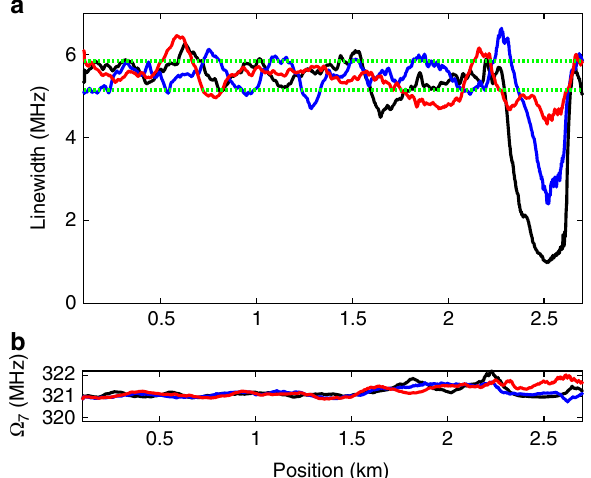
Fig. 4 Optomechanical time-domain re fl ectometry spectra. Measured normalized nonlinear coef fi cients γ (7) ( Ω ) at speci fi c fi bre locations (blue Fig. 5 Optomechanical time-domain re fl ectometry measurements. circular signs) are shown alongside fi tted Lorentzian line-shapes (red solid a Measured linewidths Γ 7 ( z )/2 π as a function of position. b Measured R γ 7 ð Þ Ω ð Þ d Ω is the traces). The nonlinear coef fi cients are normalized so that resonance frequencies Ω 7 /(2 π ) as a function of position. The standard same for all measurements. A standard, single-mode fi bre was under test. dual-layer acrylate coating was removed from a 100 m-long section of the fi bre under test, located 2.5 km from the input end. Black: